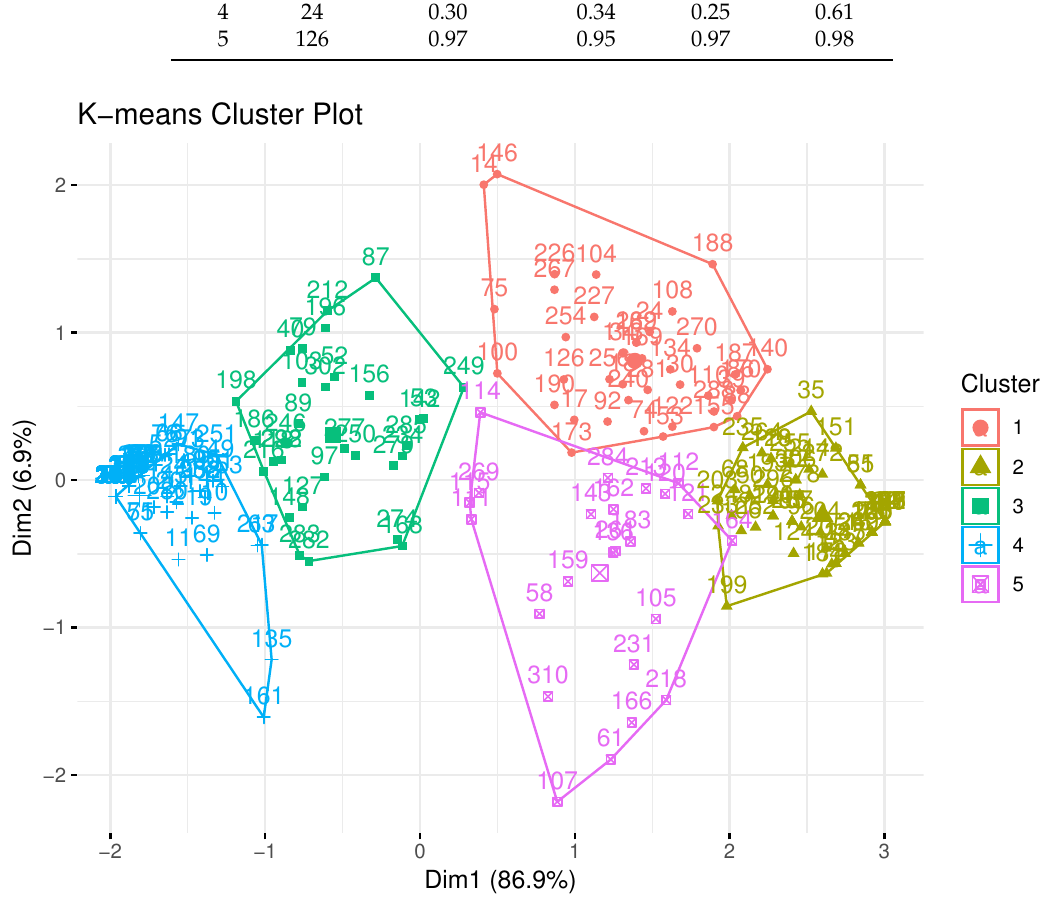
Figure 1. Employer K-means cluster